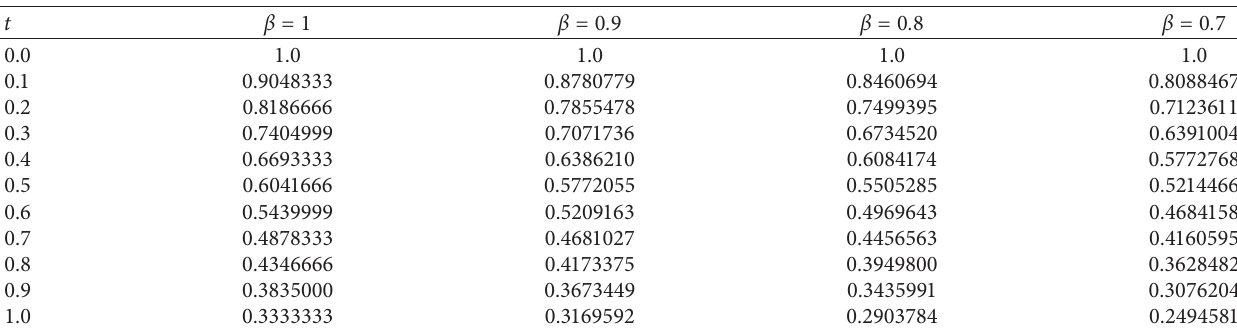
( t ) for Example 1 at different values of fractional order β , k � 6, and t ∈ [ 0 , 1 ] . 2 , 6